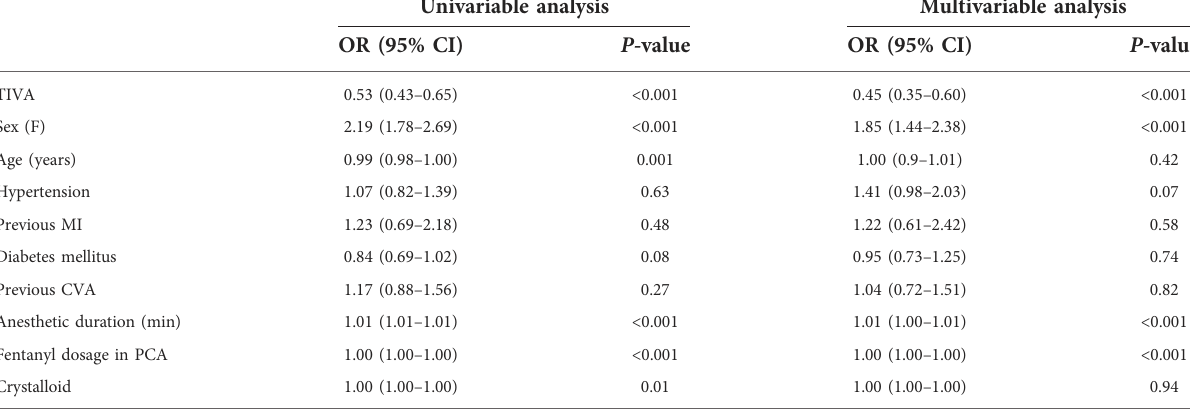
TABLE 3 Univariable and multivariable analysis of factors associated with PONV. Univariable